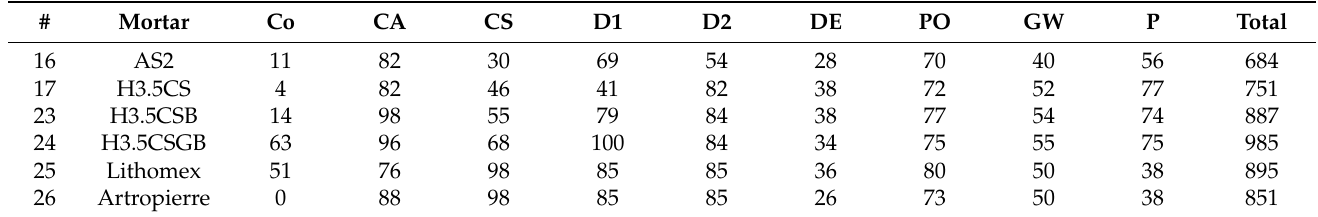
Table 13. Scores for selected mortars for Dzibichaltun site with weighed coefficients (Equation (15)).